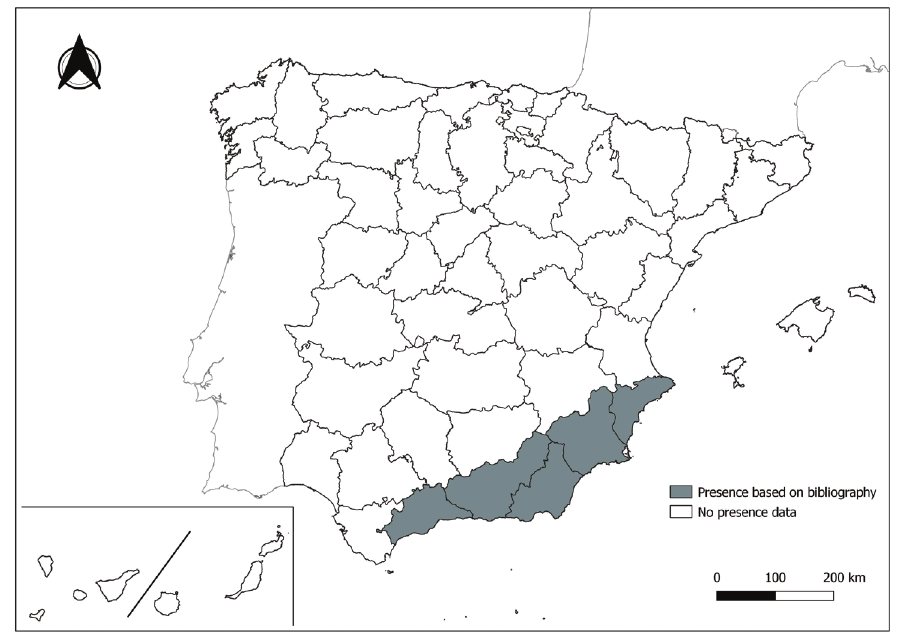
Figure 9. Distribution of Phlebotomus chabaudi in Spain.